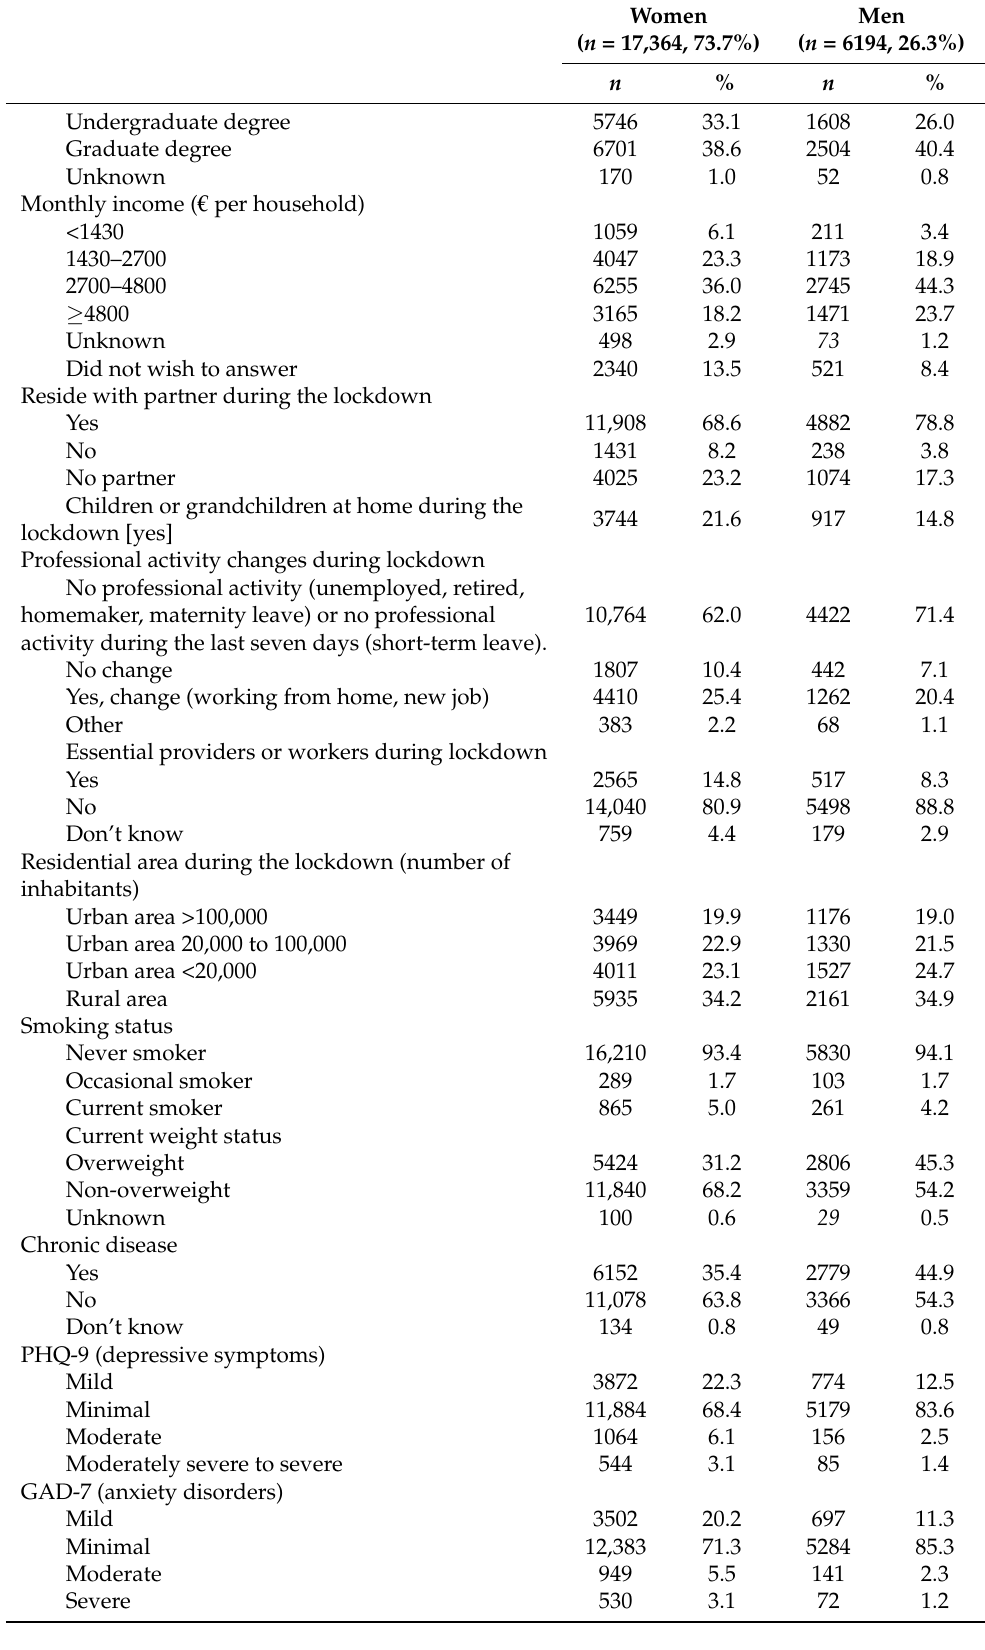
Table 1. Characteristics of the study population according to